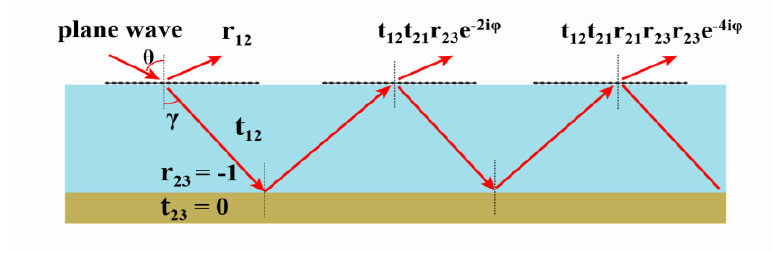
Figure 3. Schematic diagram of multiple reflections under normal incidence x -polarized.